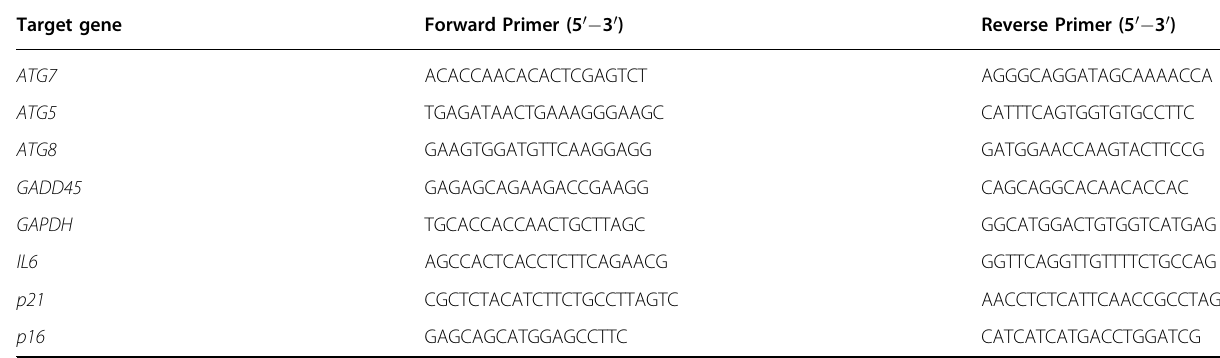
Table 1 Oligonucleotide sequences used to detect the expression of reported target genes. Target